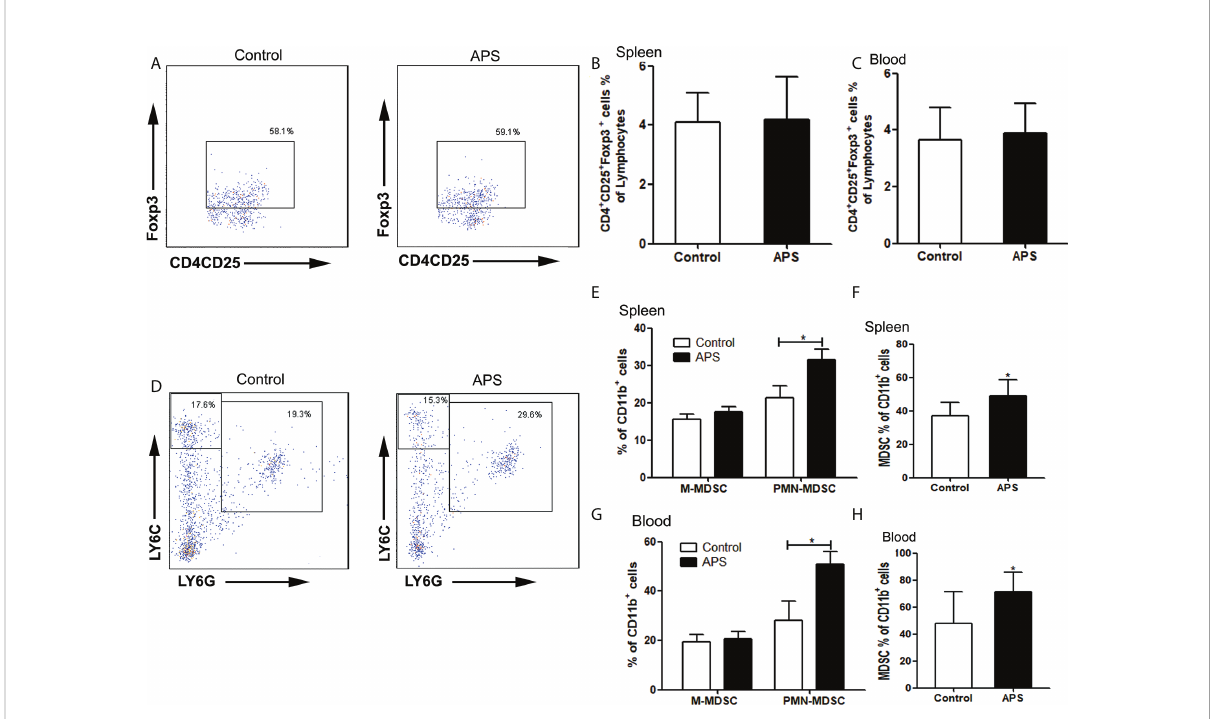
FIGURE 7 The percentages of Treg and MDSC in spleen and peripheral blood. The spleen and peripheral blood were collected from the Control/APS- treated mice. Single-cell suspensions were generated, and the cells were immune-stained for Treg 、 M-MDSC 、 PMN-MDSC and MDSC. (A, D) One representative result from each experiment is shown. The percentages of Treg cells among lymphocytes in spleen (B) and blood (C) . The percentages of M-MDSCs and PMN-MDSCs of CD11b + cells among splenocytes (E) and leukocytes in blood (G) (*p<0.05). The percentages of total MDSC among splenocytes (F) and leukocytes in blood (H) (*p<0.05). n=6, Data are expressed by mean ±